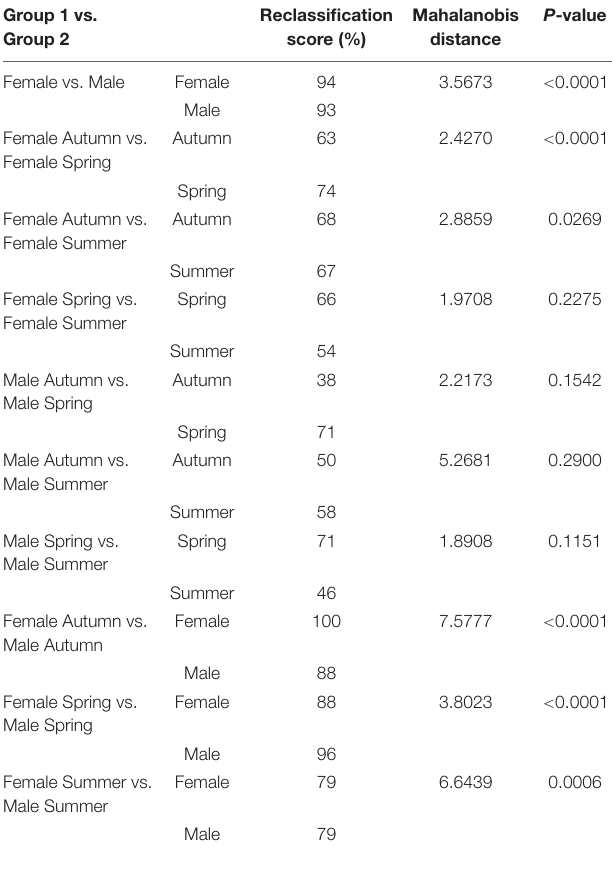
TABLE 2 | Pairwise cross-validated reclassification rates, Mahalanobis distances and P -value of males and females Ae. albopictus specimens. Group 1 vs. Group